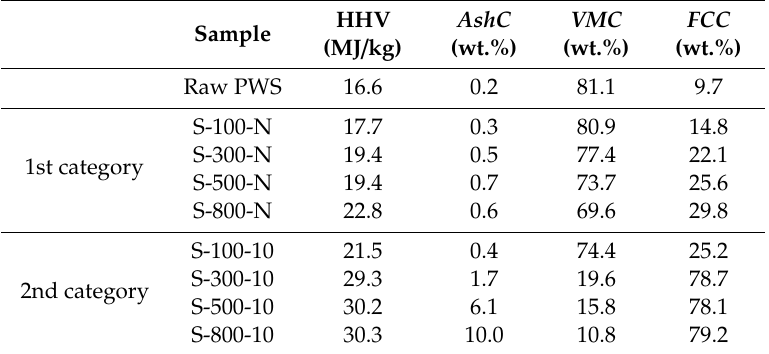
Table 2. HHV and proximate analysis results for the di ff erent MW-treated samples. Sample